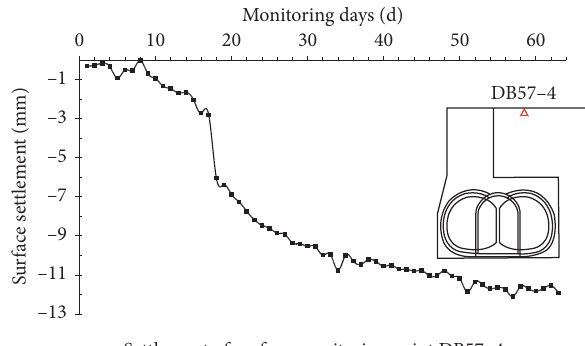
Figure 19: Surface monitoring point DB57-4 changes with monitoring days.